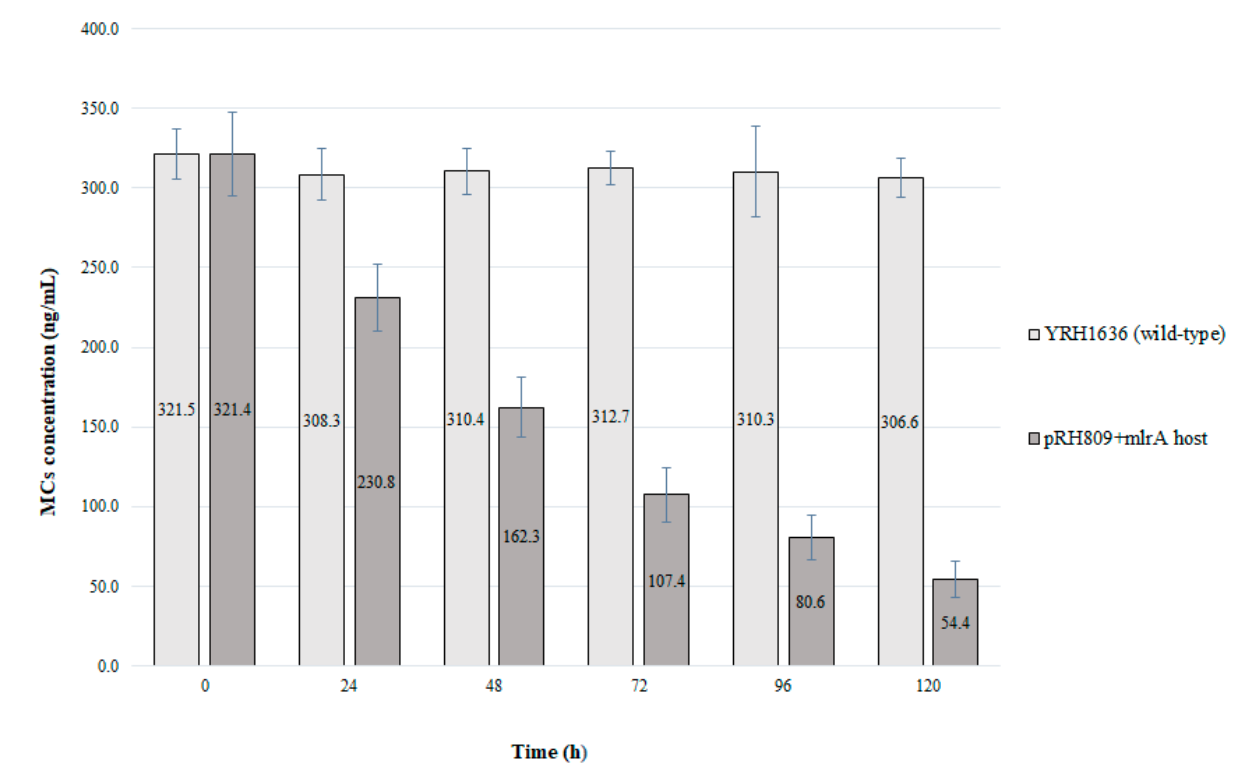
Figure 5. Time course of MC degradation test. Negative control consisted of the wild-type yeast (YRH1636). For the negative control, there was no difference among the mean concentrations of MCs during all the time of cultivation. For the strain with pRH809+ mlrA , MC content differed among all the analyzed times ( p < 0.05).